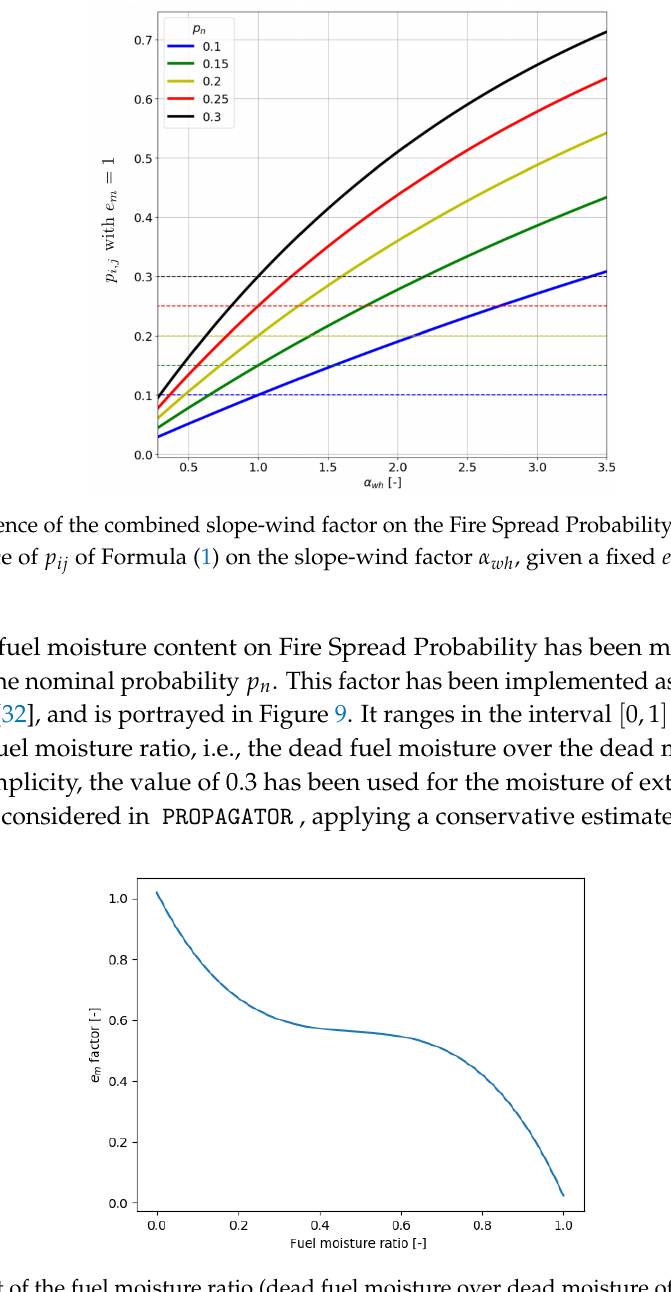
Figure 9. Effect of the fuel moisture ratio (dead fuel moisture over dead moisture of extinction) on the Fire Spread